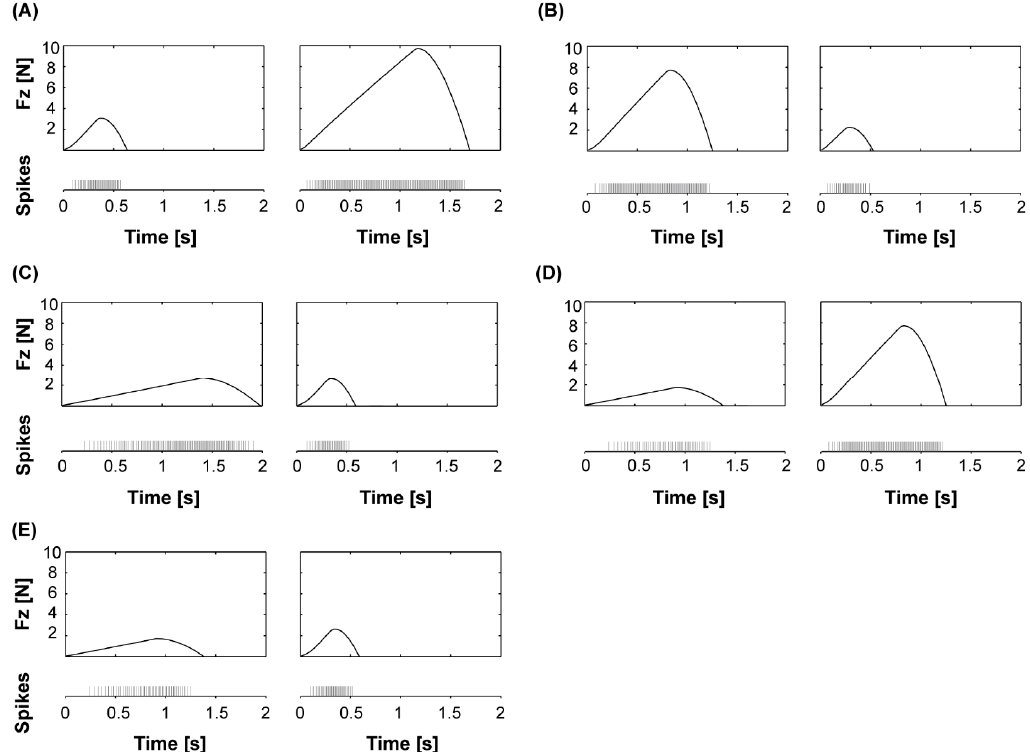
Figure 2. Example combinations of stimulus pairs presented in the experimental protocol. In each experimental trial, the rubber pair, the force and the duration used to indent each rubber sample were randomized, in order to guarantee a very challenging evaluation condition. The panels of this figure show some selected stimulation conditions. ( A ) Material 1 slightly stiffer than material 2: softer rubber sample indented with higher force (resulting in longer stimulation duration for the softer rubber sample); ( B ) Material 1 slightly stiffer than material 2: stiffer rubber sample indented with higher force (resulting in longer stimulation duration for the stiffer rubber sample); ( C ) Material 2 stiffer than material 1: both rubber samples indented with the same force (resulting in longer stimulation duration for the softer rubber sample); ( D ) Material 2 stiffer than material 1: indentation duration kept constant (resulting in stiffer rubber sample being indented with a higher force); ( E ) Material 2 stiffer than material 1: softer rubber sample indented with longer duration (resulting in lower level of indentation force for the softer rubber sample).